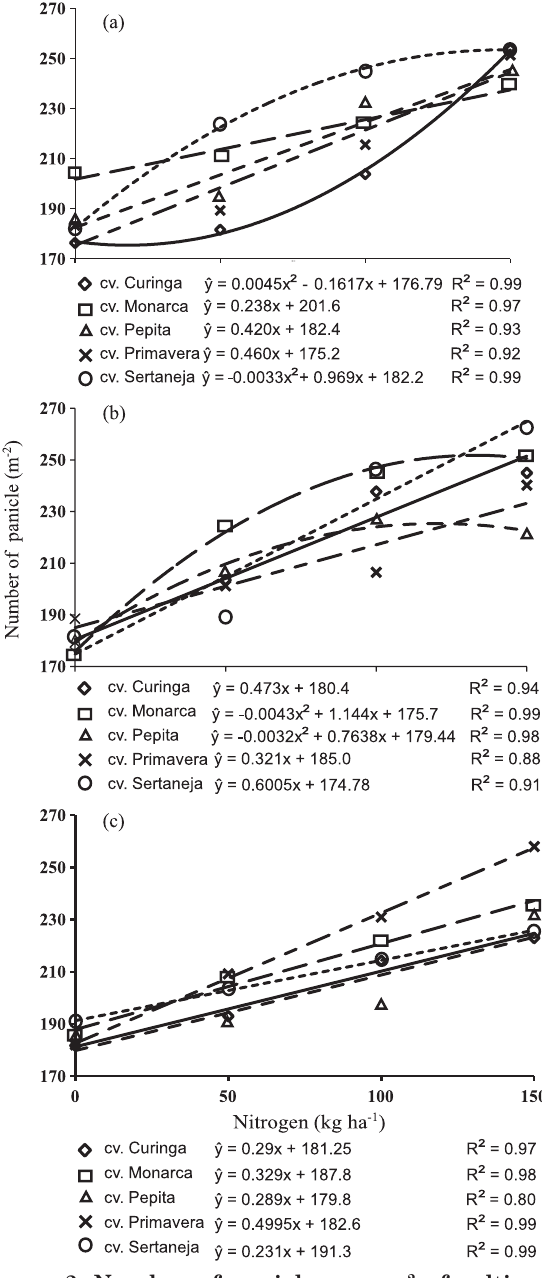
figure 2. number of panicles per m 2 of cultivars as a function of n rates and application times 100 % applied at planting (a); 50 % at sowing and 50 % at tillering (b); and 100 % at tillering